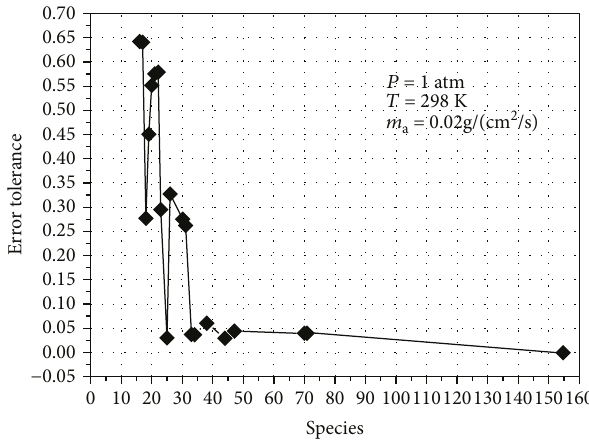
Figure 5: Relationship between number of species and calculated